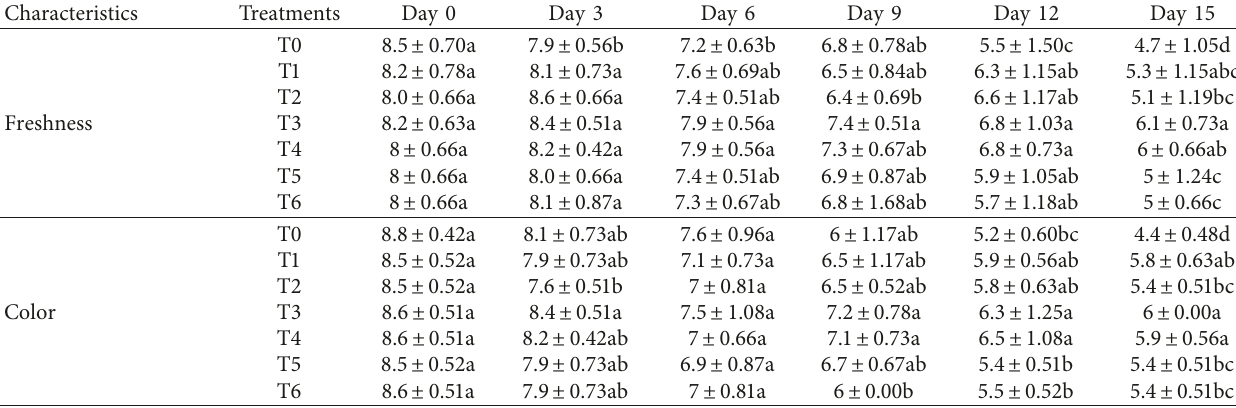
Table 3: Effect of chitosan and cinnamon essential oil coatings on sensory evaluation of pomegranate arils during storage. Characteristics